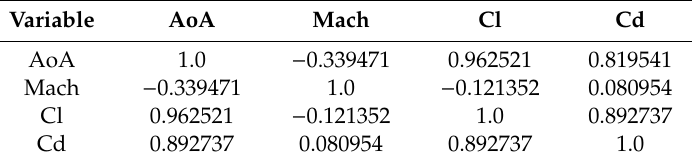
Table 8. Pearson correlation coefficients in DPW databases.